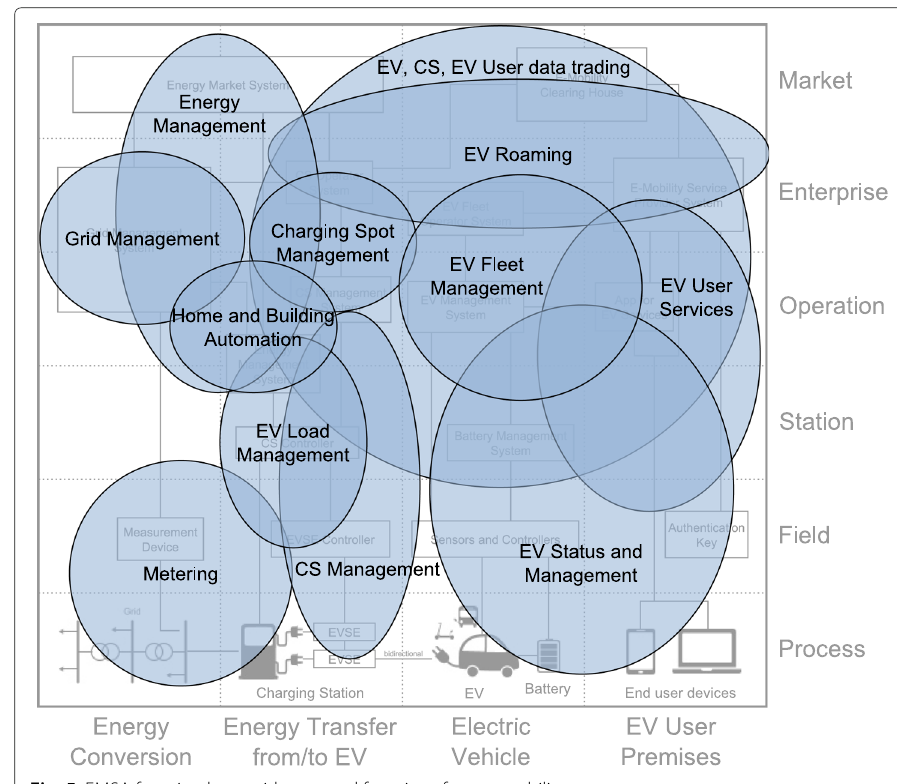
Fig. 5 EMSA function layer with grouped functions from e-mobility